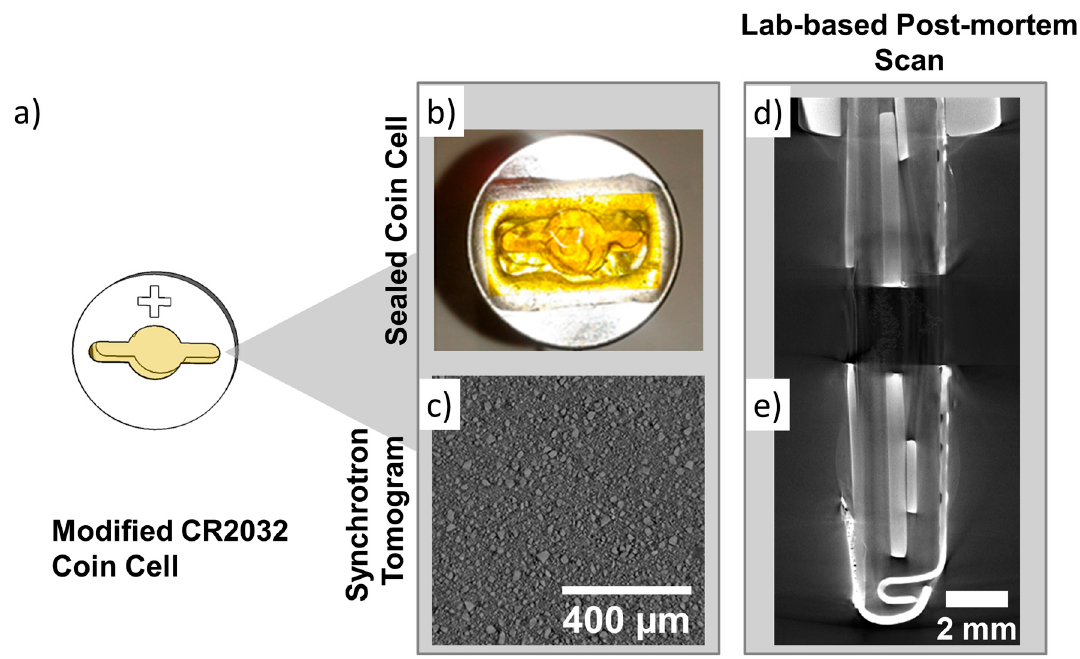
Figure 2. ( a ) Modified CR2032 coin cell rendering and ( b ) image of the Kapton window attached to the cell. ( c ) Reconstructed slice of a LiMnO 2 electrode acquired at a synchrotron facility and ( d , e ) post-mortem CT scan of the entire cell showing its components.